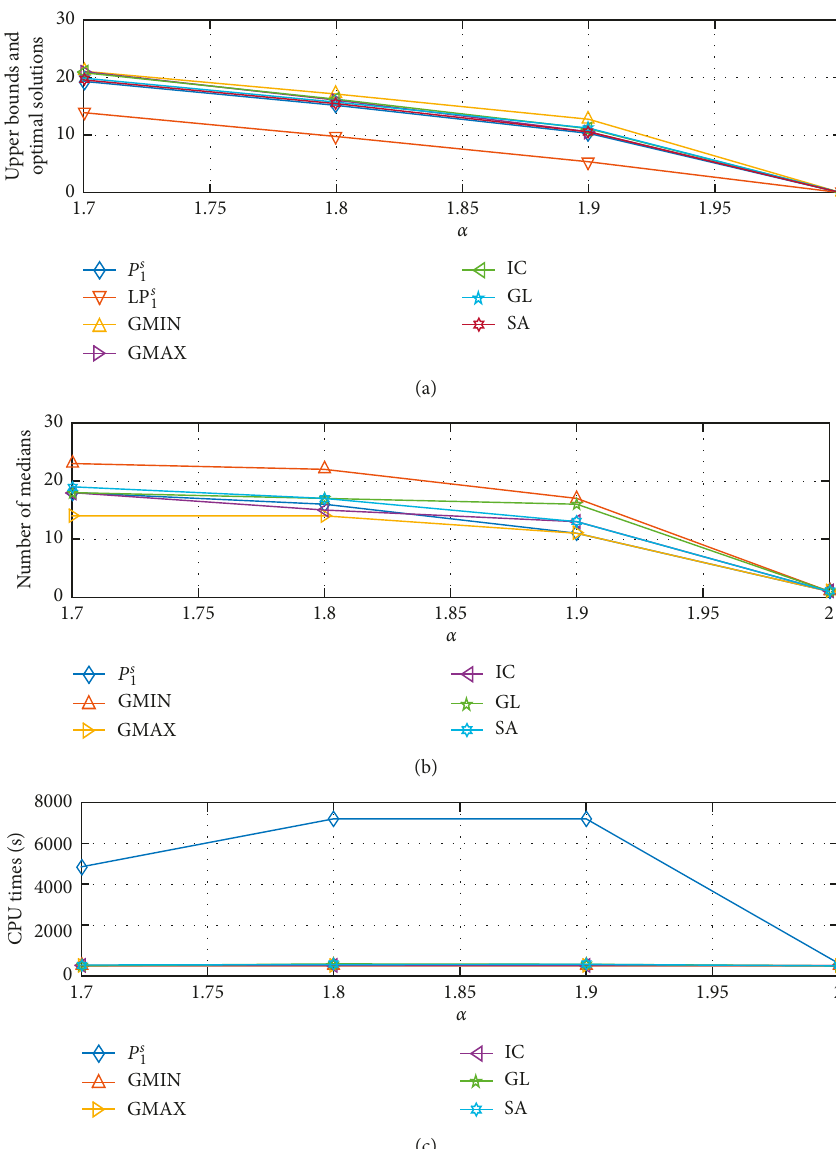
Figure 4: (a) Upper bounds and optimal solutions, (b) number of facilities, and (c) CPU times in seconds for the instance #11 in Table 1 while varying α ∈ [ 1 . 7 ; 2 ] and using a radial coverage value of 0.2km.